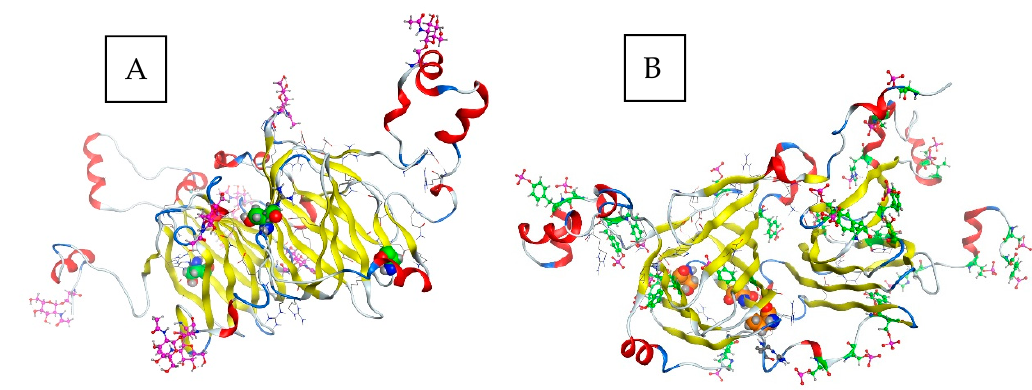
Figure 4. Homology modeling of the vicilin storage protein. ( A ) Postulated glycosylation (O-GLcNAc) and ( B ) phosphorylation sites (both in pink) in the storage protein vicilin from Theobroma cacao (entry: Q43358; UniProt: http://www.uniprot.org/; 28th January, 2019). The data indicate that the modifications (illustrated in green/orange spacefilling model) as reported in [50] are most probably occurring after the proteolytic processing of the 66 kDa precursor [9,22]. Please see supplementary information provided.